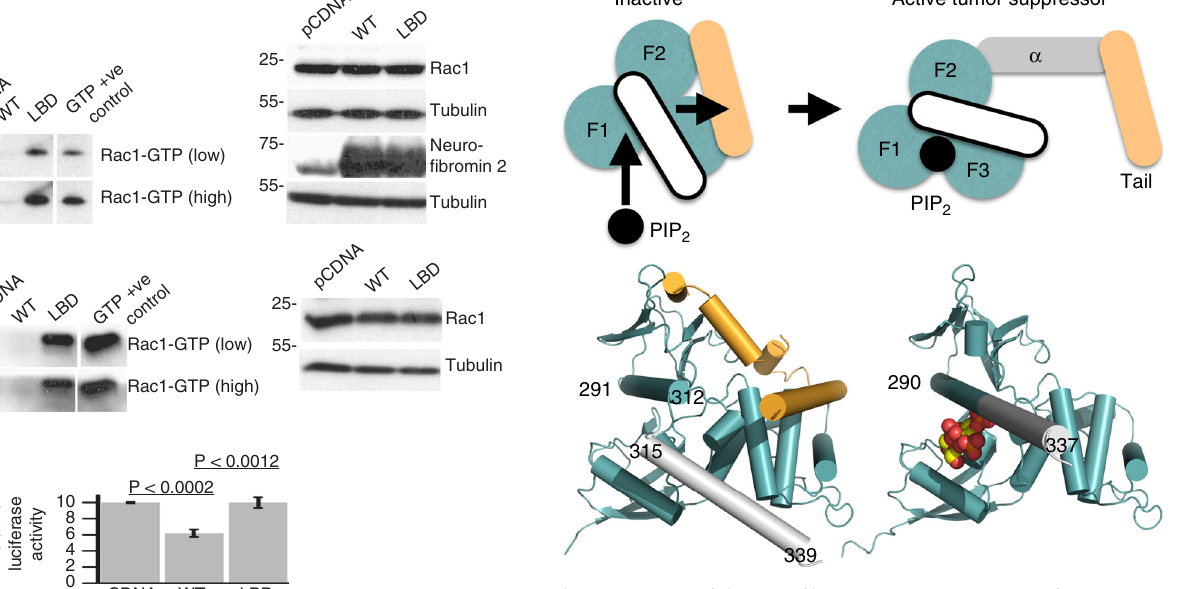
Fig. 6 Activation of the neuro fi bromin 2 tumor-suppressive function. In its inactive state, neuro fi bromin 2 is in a closed conformation through interactions of the FERM domain (teal; F1, residues 18 – 98; F2, residues 111 – 213; F3, residues 220 – 312) and the tail domain (pale orange). The α - helix C -terminal of F3 (residues 315 – 339; white) does not interact with the tail domain. PIP 2 binds to F1 and the last α -helix (residues 291 – 312; not depicted) of F3, thereby causing the last F3 α -helix (residues 291 – 312) and the following α -helix α H (residues 315 – 339) to rearrange as one long and continuous α -helix (residues 290 – 337), thereby displacing the tail domain and severing the head – tail interaction which results in active tumor suppressor functions. The central α -helical domain is shown in gray. The head/tail neuro fi bromin 2 crystal structure (head structure from PDB entry 1isn 34 ; tail structure from PDB entry 4zrj 35 ) is shown below the schematic on the bottom left and our PIP 2 -bound structure on the bottom right